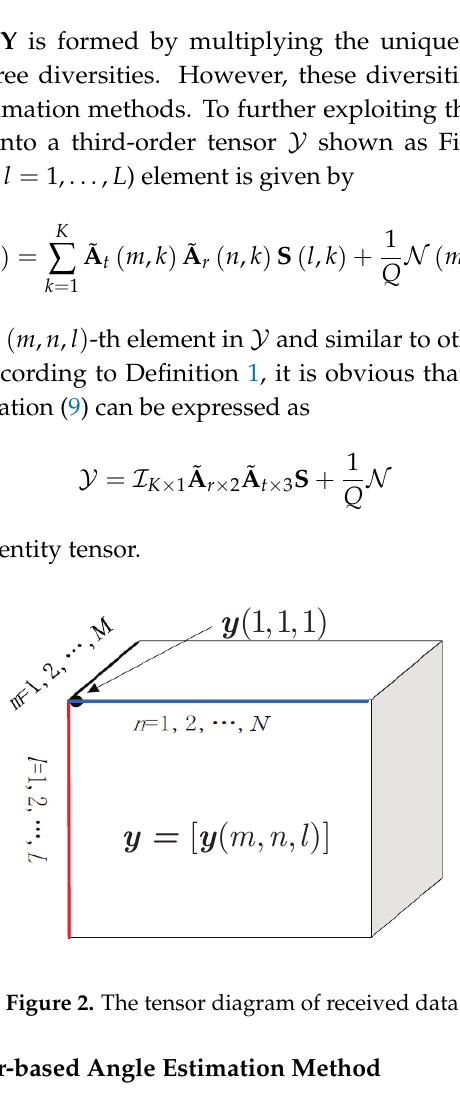
Figure 1. Bistatic MIMO radar configuration.